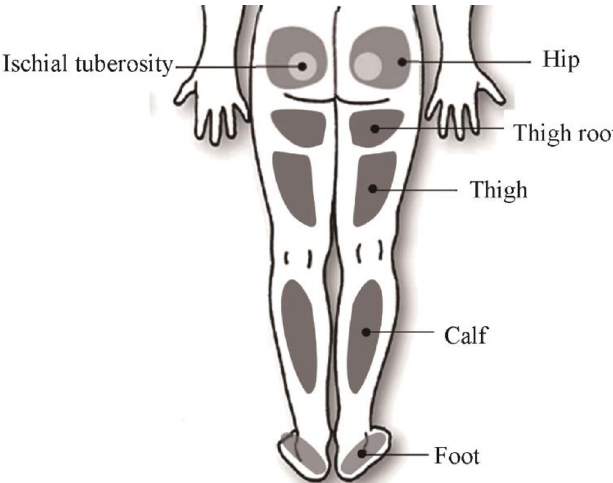
Fig 7. Schematic diagram of the body perception area below the test